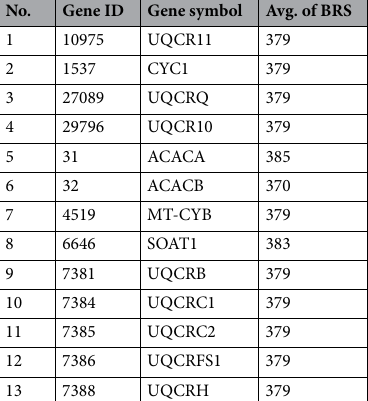
No. Gene ID Gene symbol Avg. of